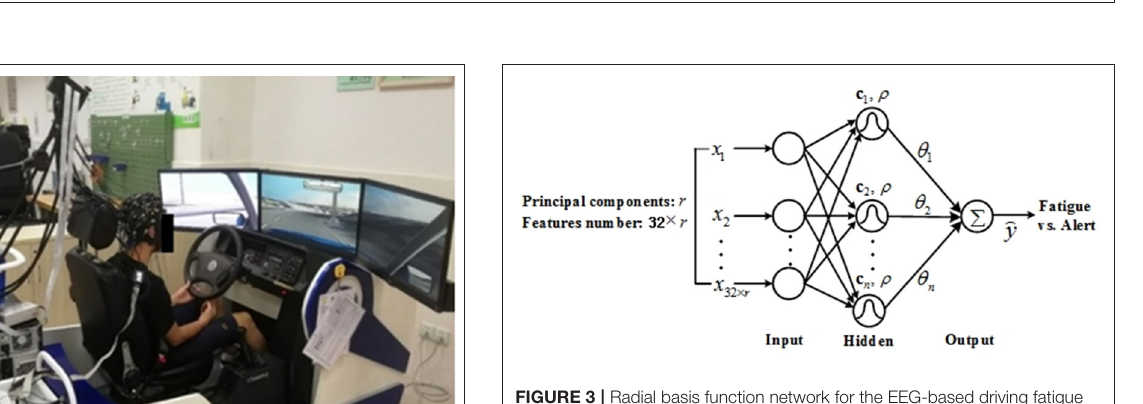
FIGURE 1 | Schematic illustration of the two-level learning hierarchy radial basis function network.